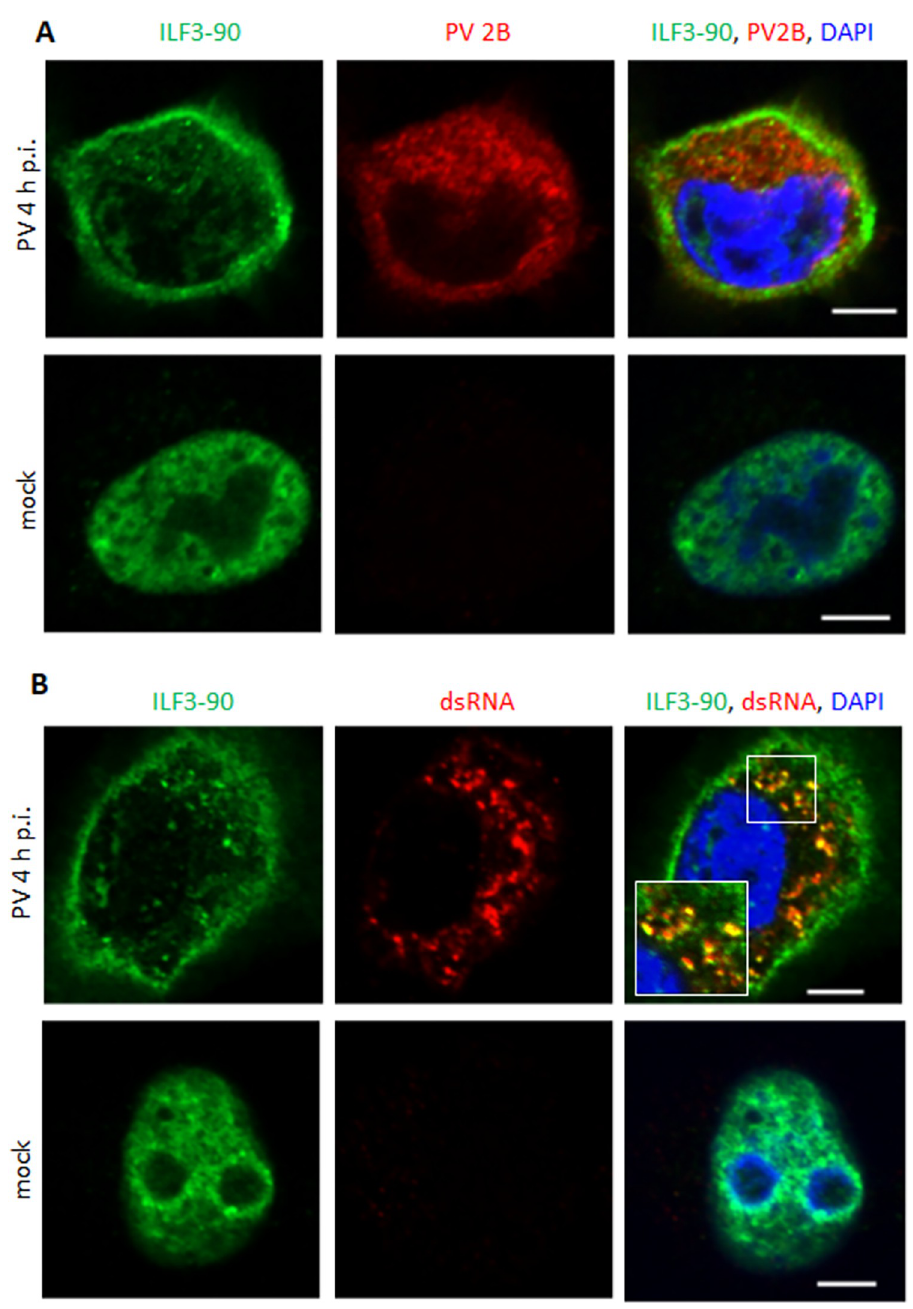
Fig 8. ILF3-90 associates with dsRNA in poliovirus-infected cells. A, B. Confocal images of HeLa cells infected (or mock-infected) with 10 PFU/cell of poliovirus, fixed at 4 h p.i. and stained with antibodies against ILF3-90 and the viral antigen 2B ( A ), or ILF3-90 and dsRNA ( B ). Scale bar is 10 μ m. Note the concentration of ILF3-90 signal on the outer border of the replication organelles and its association with dsRNA inside the replication organelles.